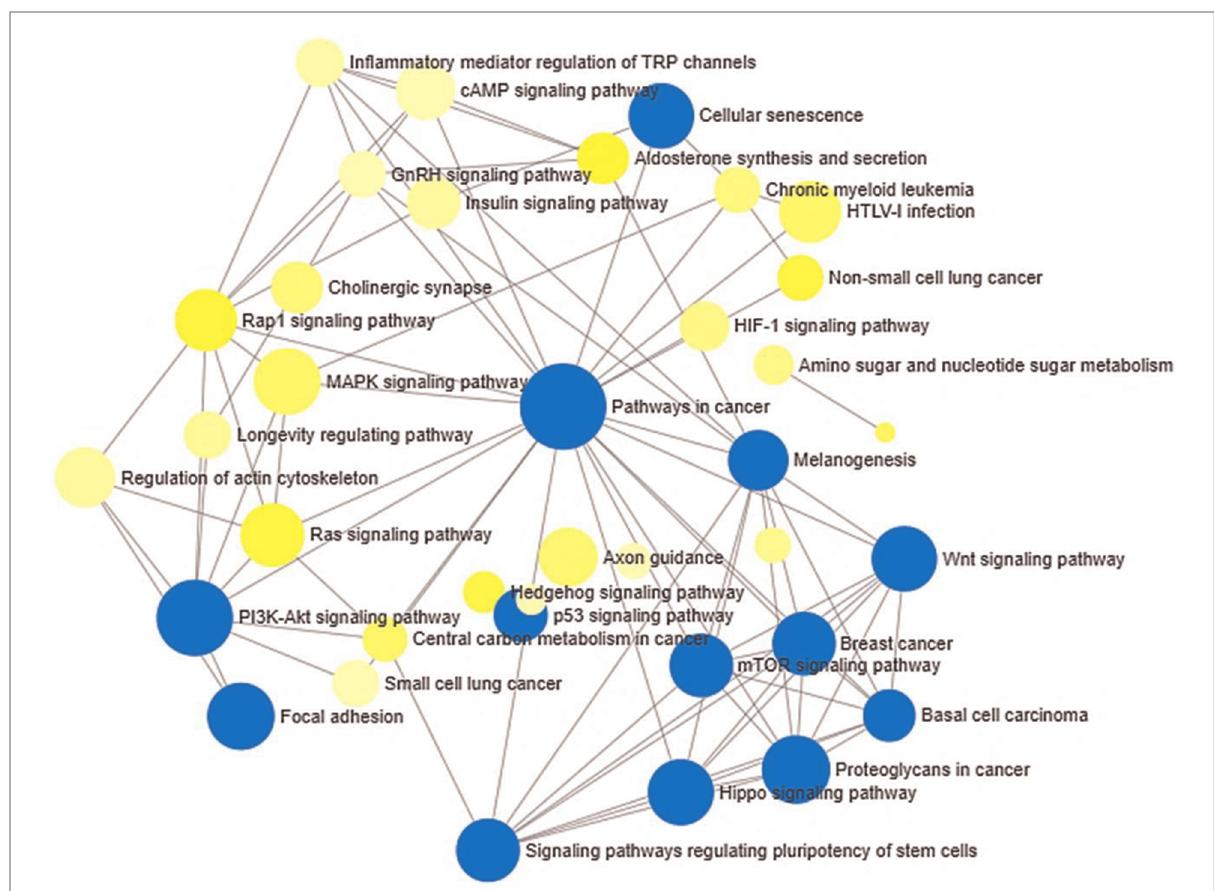
FIGURE 5 Network analysis of KEGG pathways enriched by annotated differentially methylated (hypo- and hypermethylated) gene in low vs. high stigma. Node sizes are proportional to the number of differentially methylated genes. Blue node=adj. p <0.05 using the hypergeometric tests in Network